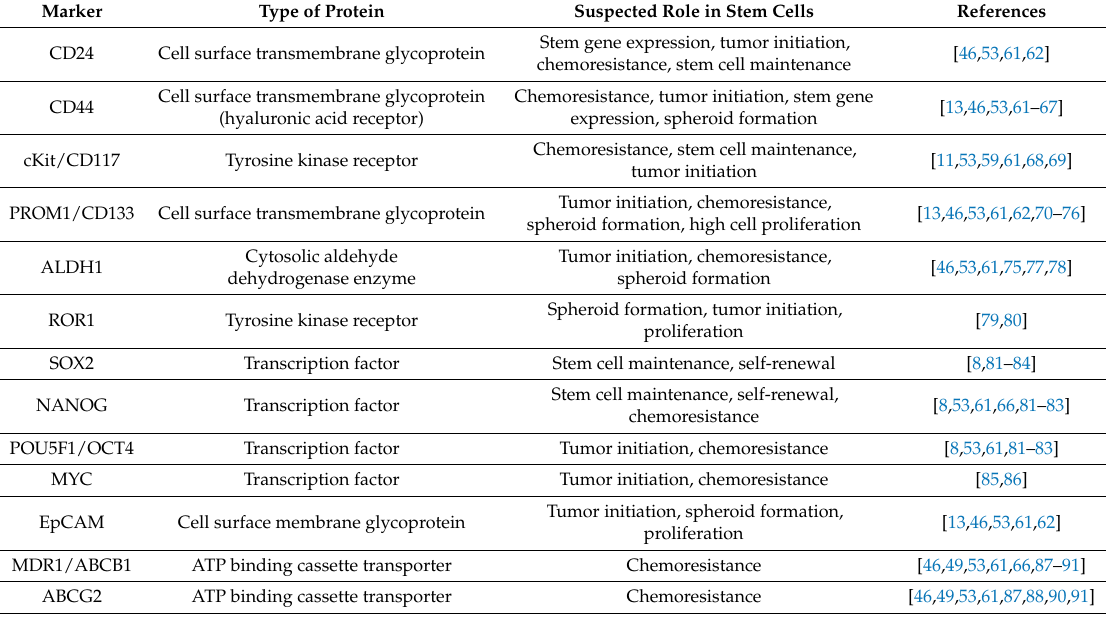
Table 1. Putative Ovarian Cancer Stem Cell